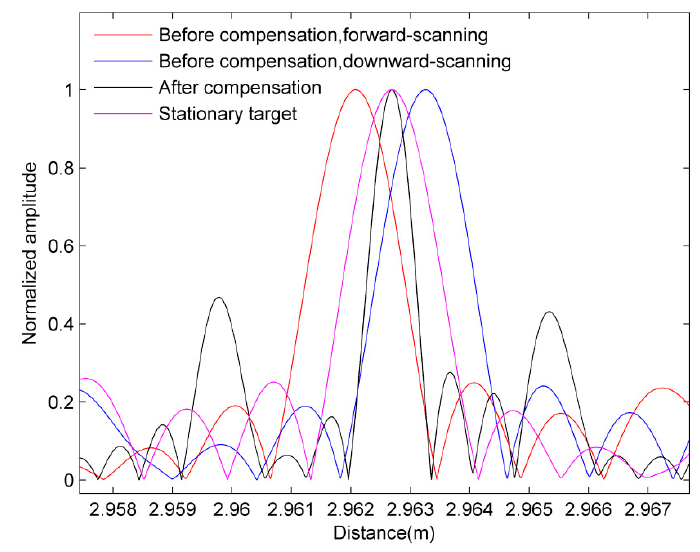
Figure 3. Distance spectrum before and after the vibration compensation at the frequency of 1 Hz and the amplitude of 10 μ m.